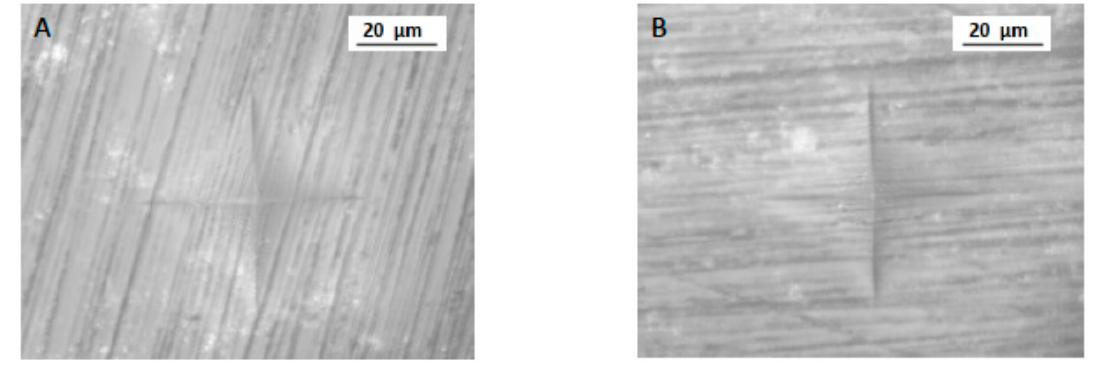
Figure 3. VHN indentation for CAD-CAM samples (group CC). A and B are two different samples from the same group.